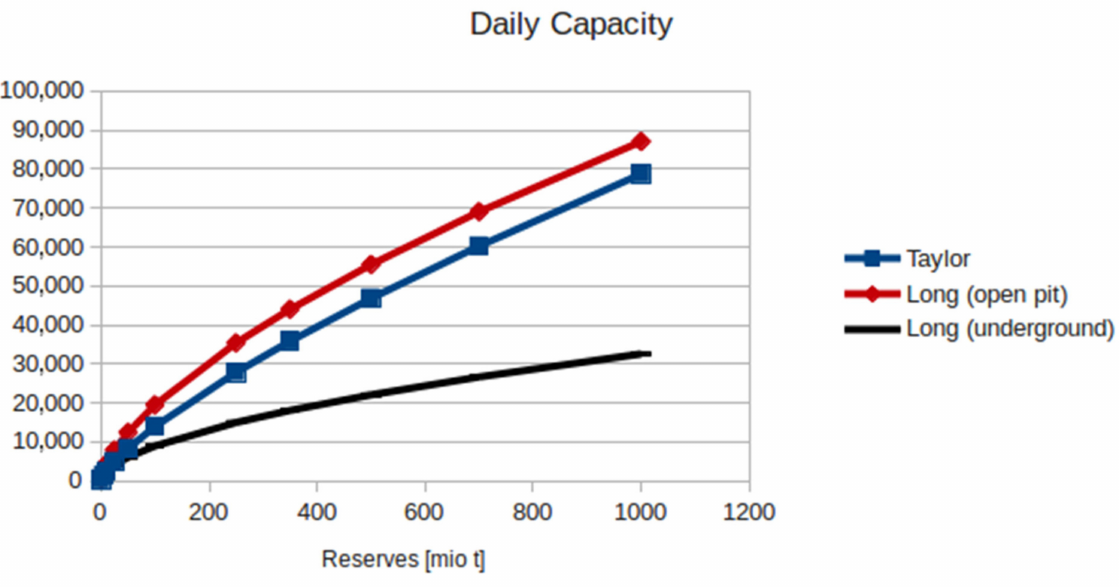
Figure 3. Comparison of Taylor’s and Long’s relationships between reserves and capacity [18] (with permission of Bolet í n Geol ó gico y